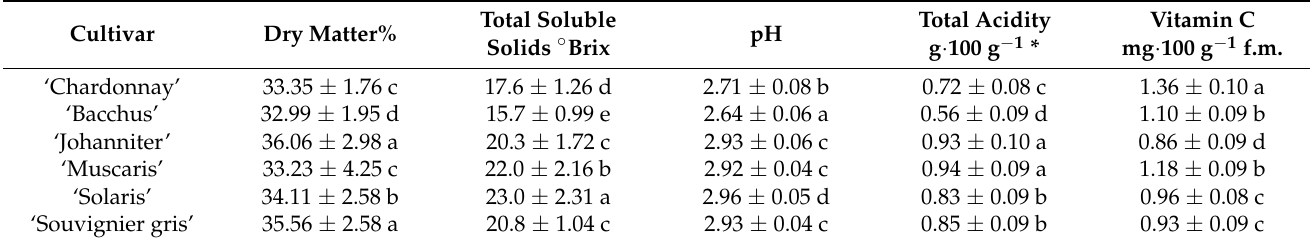
Table 2. Dry matter content, total soluble solids, pH, acidity, and vitamin C of grape samples.